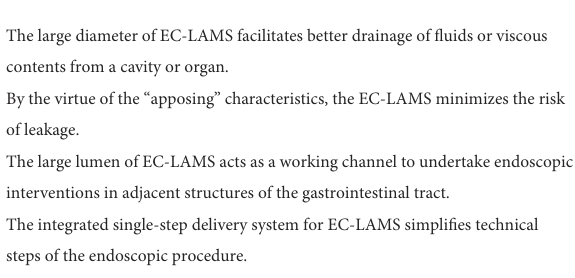
TABLE 2 Summary of the unique characteristics of EC-LAMS compared with double pigtail plastic stents. The large diameter of EC-LAMS facilitates better drainage of fluids or viscous contents from a cavity or